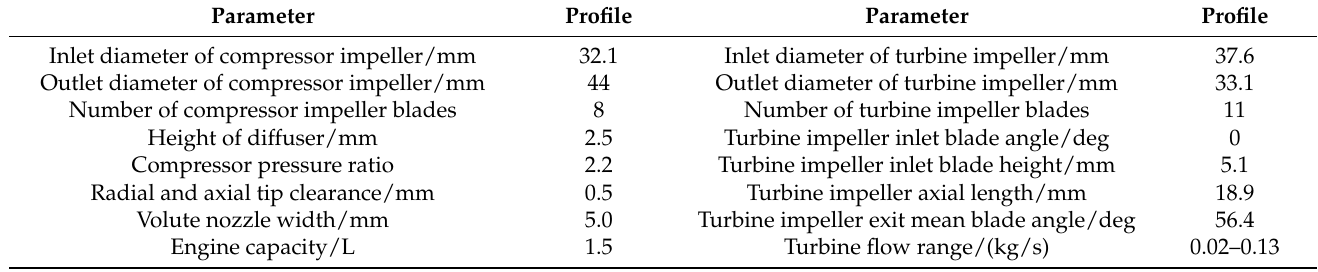
Figure 2. Three-dimensional structure model. Table 1. Turbocharger parameters.